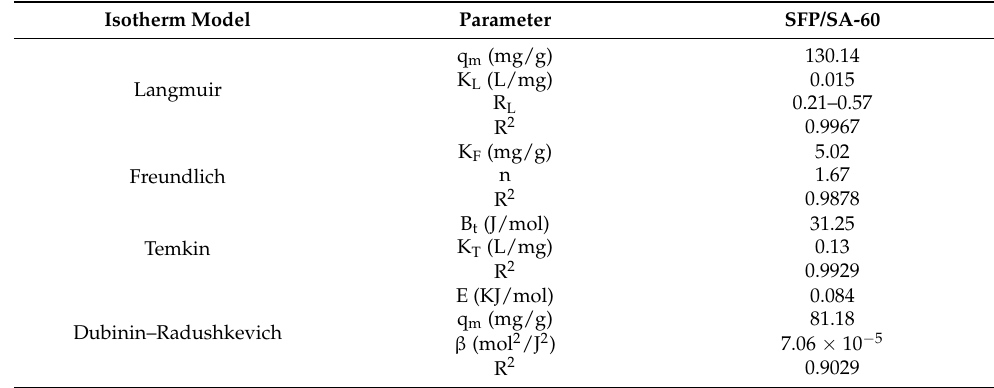
Table 3. Langmuir, Freundlich, Temkin and Dubinin–Radushkevich model isotherm parameters for CV Adsorption by SFP/SA at 25 ◦ C.